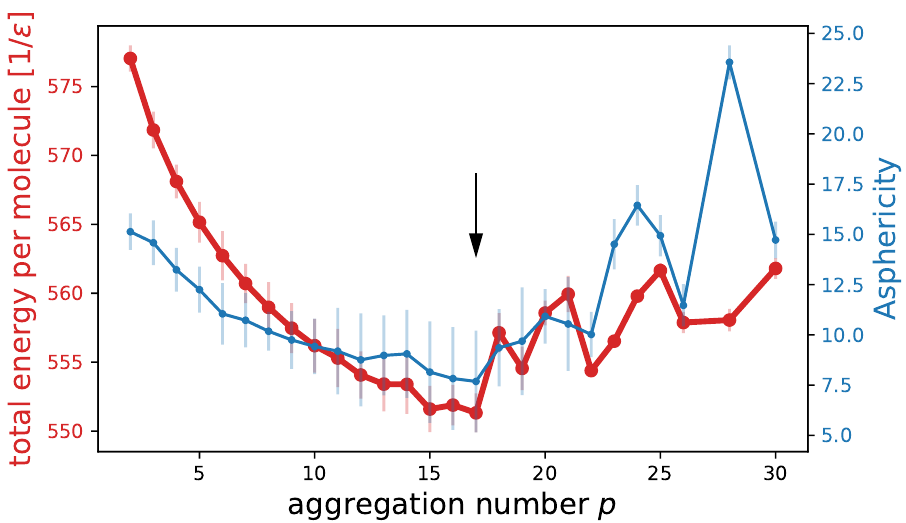
Figure 3. Total energy per macromolecule (left) and asphericity (right) versus aggregation number. The arrows indicate the equilibrium aggregation number. Other system parameters: N A = 25, N B = 5 ( g = 0), w c = 1.6, k B T = 1.0, (cid:101) attr = 1.0.